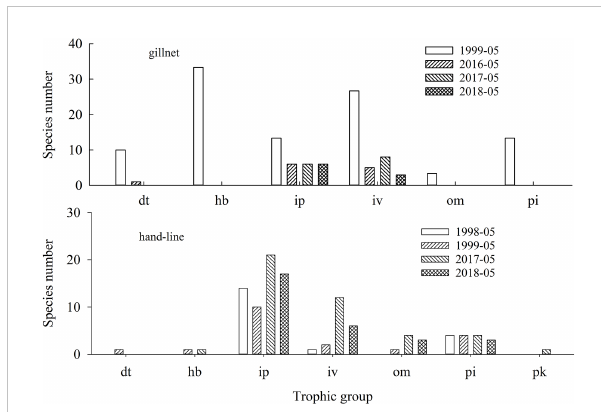
FIGURE 3 Species number of different trophic fi sh in the lagoon of Meiji Reef in the South China Sea between 1998 — 1999 and 2016 — 2018. The dt, hb, ip, iv, om, pi and pk mean detritivores, herbivores, piscivores, invertebrate feeders, omnivores, invertebrate feeder & piscivores, and planktivores, respectively.